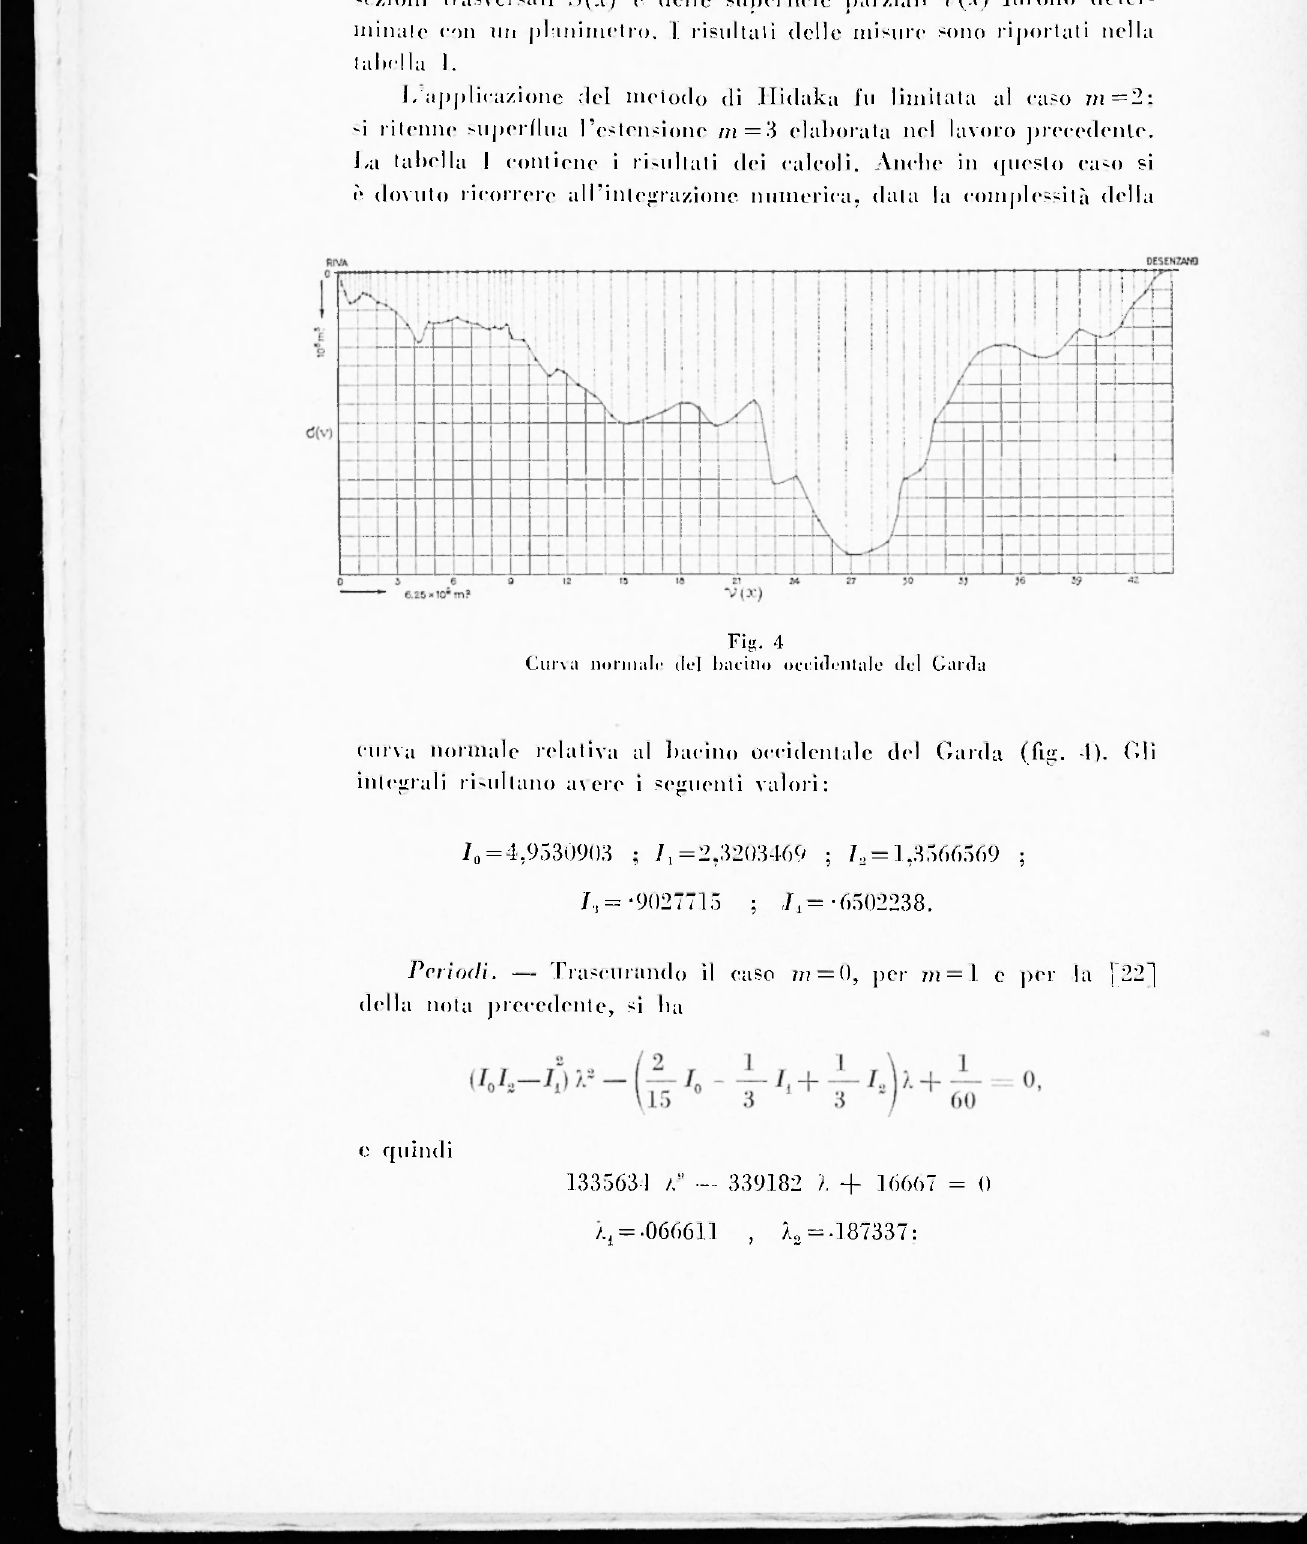
Fig. 4 Curva normale del bacino occidentale del